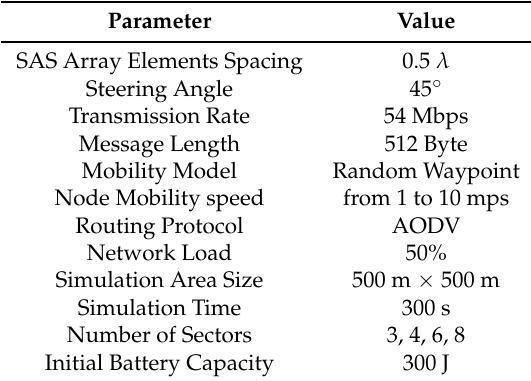
Table 1. Main simulation parameter